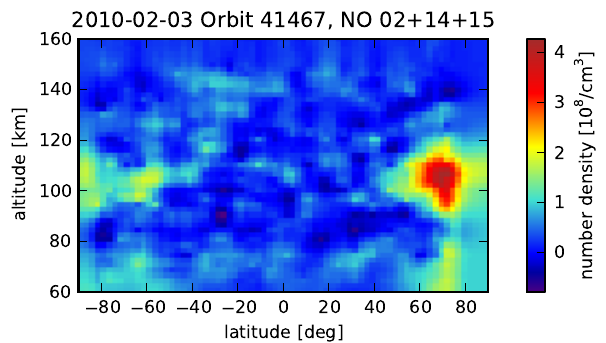
Fig. 5. Retrieved NO number densities along the sample orbit (no. 41467, 3 February 2010).